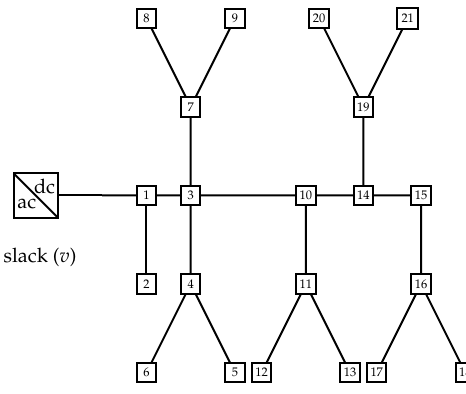
Figure 2. Grid configuration of the 21-bus system. Table 1. Data for the 21-bus system (all powers in